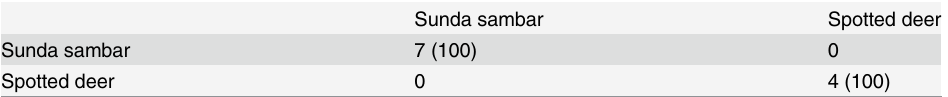
Table 5. Classification result of species prediction using elemental profiling of antlers from two spe- cies of